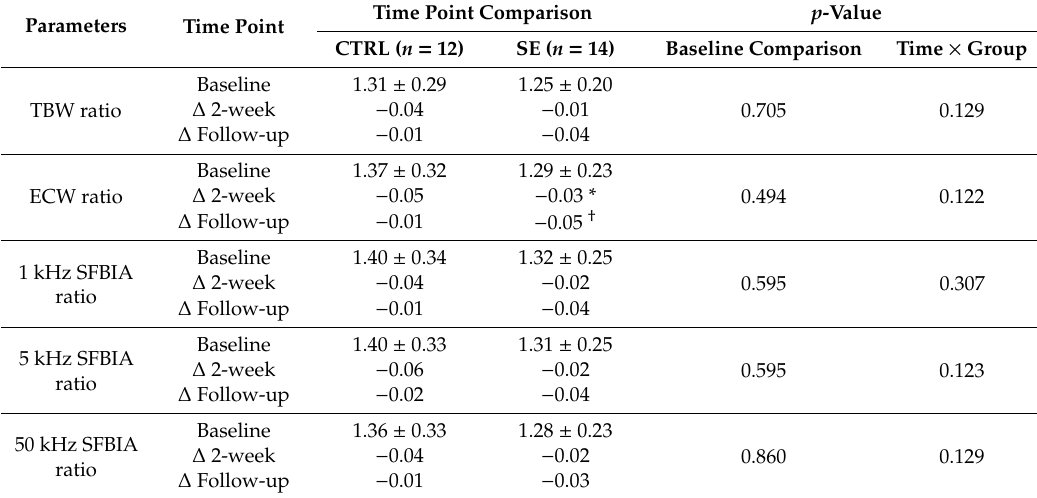
Table 2. Changes in bioelectrical impedance values during the